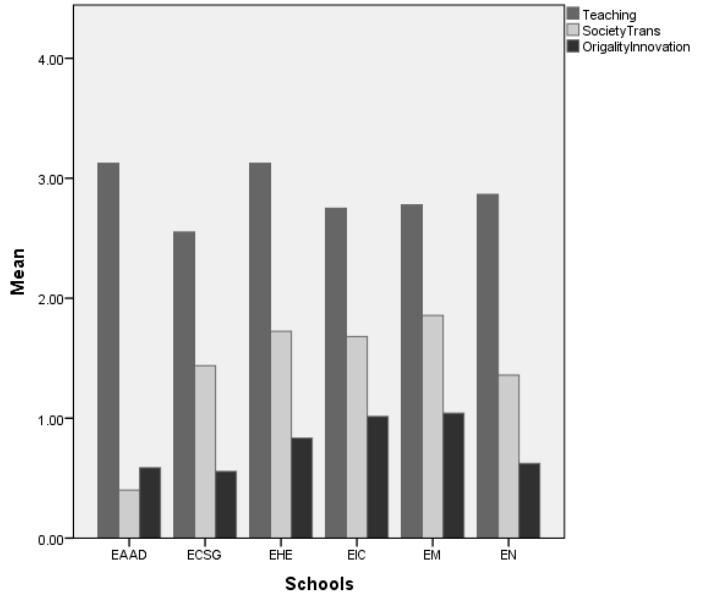
Figure 8. Teaching, Transformation of Society, and Originality and Innovation competency levels by school. Source: Authors.